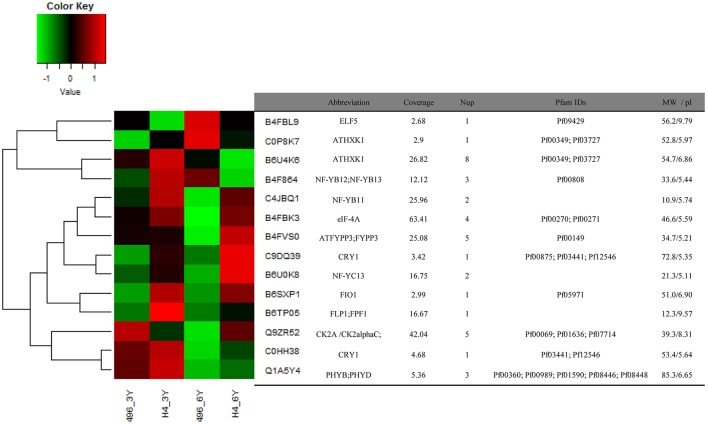
Expression patterns of 14 identified proteins associated with light and photoperiod response in maize Huangzao4 (HZ4) and H496 grown under long-photoperiod conditions. The heatmap was plotted using log2 values and scaled from a change of -1 to 1 log2 change.